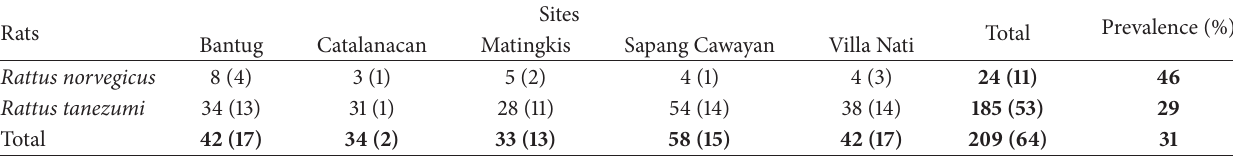
Table 2: Rats examined for Angiostrongylus cantonensis infection in Mu˜noz, Nueva